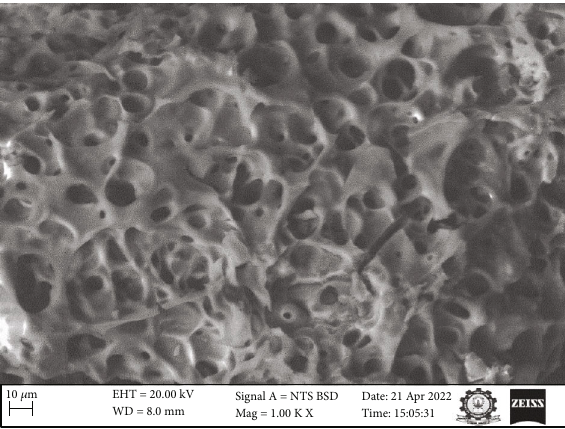
Figure 2: SEM image of CTASP after adsorption of dye.